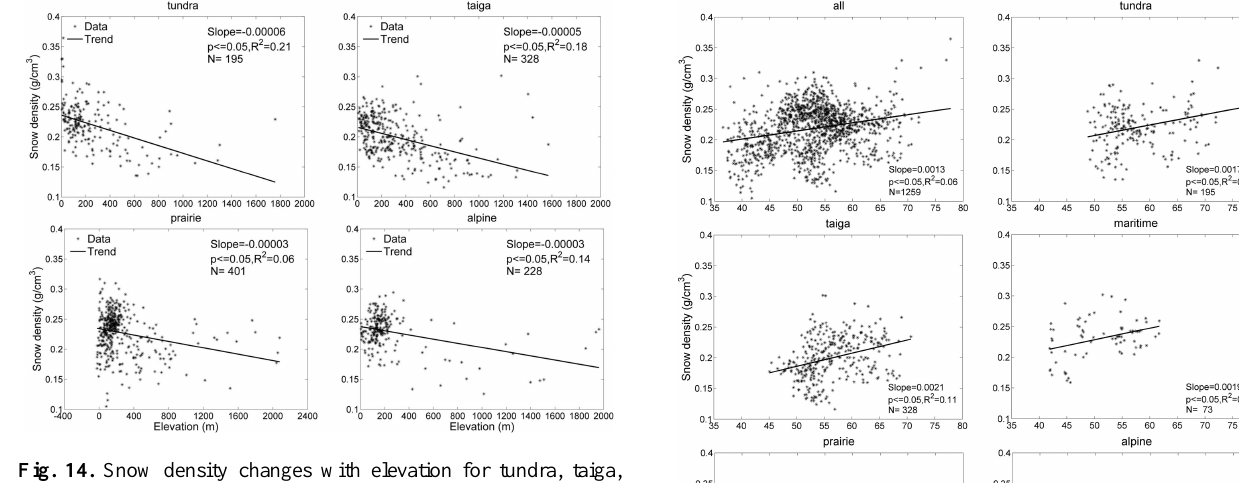
Fig. 14. Snow density changes with elevation for tundra, taiga, prairie, and alpine snow. Asterisks show the mean snow density of each site; the thick line is a linear regression with the parame- ters shown on the upper-right corner, where Slope is the slope of − 0.006 in gcm − 3 − 100m, p is the confidence level for the coeffi- cient estimates, R 2 is the goodness of fit coefficient, and N is the number of stations.